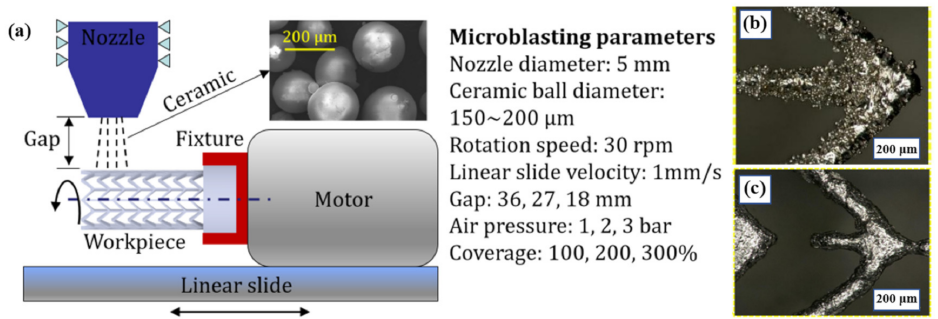
Figure 18. Micro-blasting of SLM-ed tubular lattice structure. ( a ) setup. ( b ) lattice structure before micro-blasting. ( c ) after